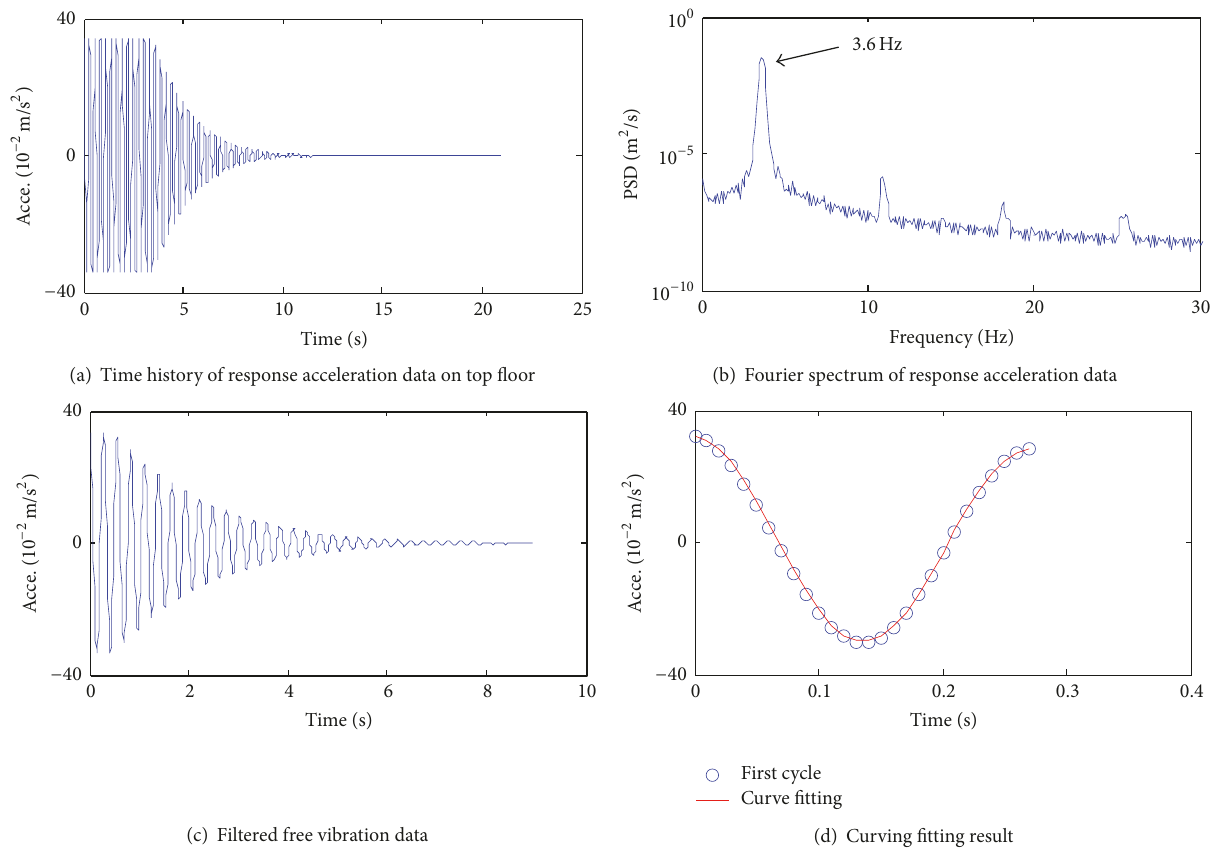
Figure 10: Data processing procedure of free vibration test data of Case 3